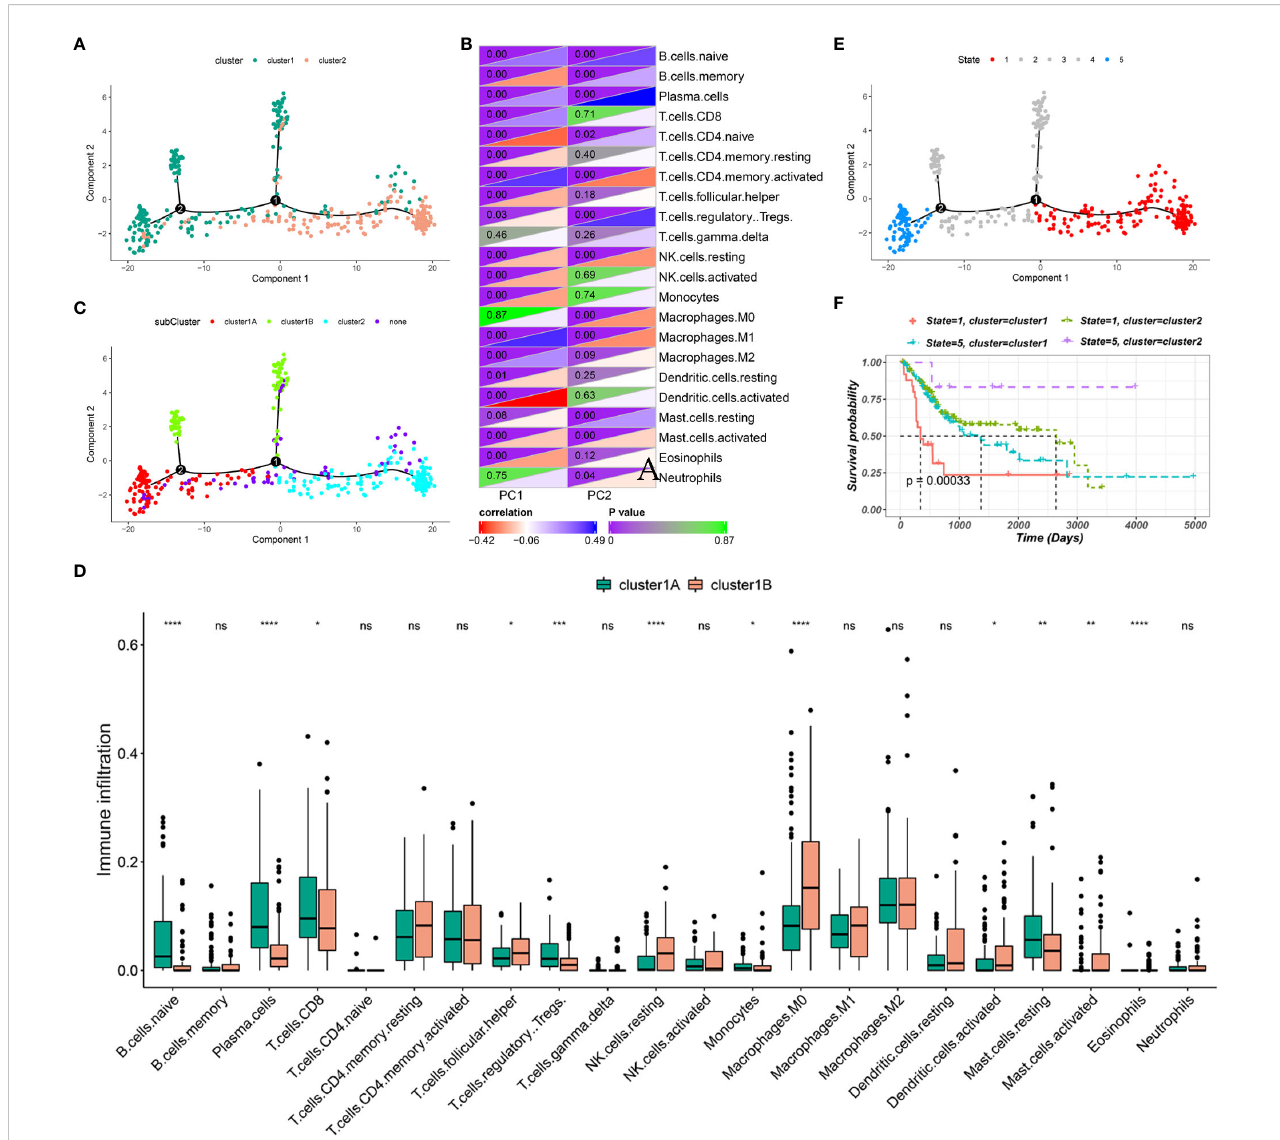
FIGURE 6 Immune landscape of BLCA. (A) Immune landscape of BLCA. Each point represents a patient, and the immune clusters are color-coded. (B) Correlation between two principal components and immune cells. (C) Immune landscape of the subclusters of BLCA immune clusters. (D) The proportion of certain immune cells in the IC1A – B subclusters. (E) Immune landscape of samples from fi ve extreme locations and (F) their prognoses. *P < 0.05, **P < 0.01, ***P < 0.001, ****P < 0.0001; ns, not signi fi